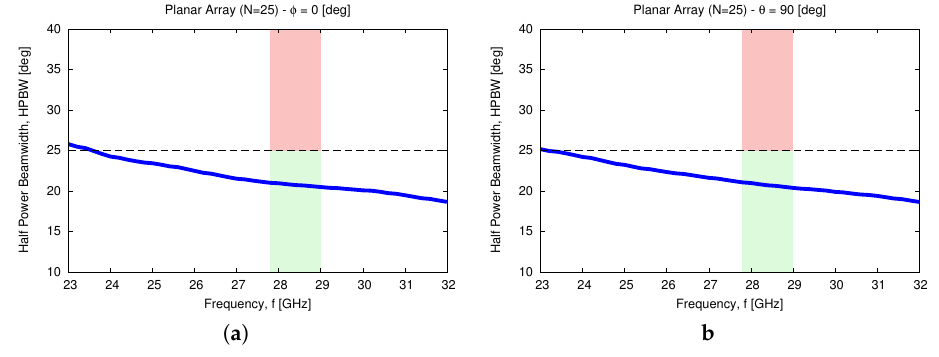
Figure 10. Planar array assessment ( N = 25, realized gain, G max ( f ) , versus the frequency.